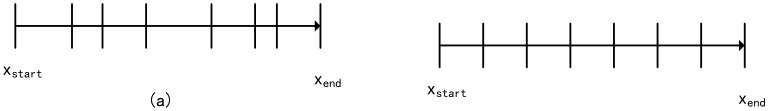
The random method and average method in criteria dimensionality.Every sub-figure in Fig. 2 is divided into 7 groups. Sub-figure (a) is the figure of random division method. In this method, the length of each group is random. Sub-figure (b) is the figure of average division method. In this method, the length of each group is average.